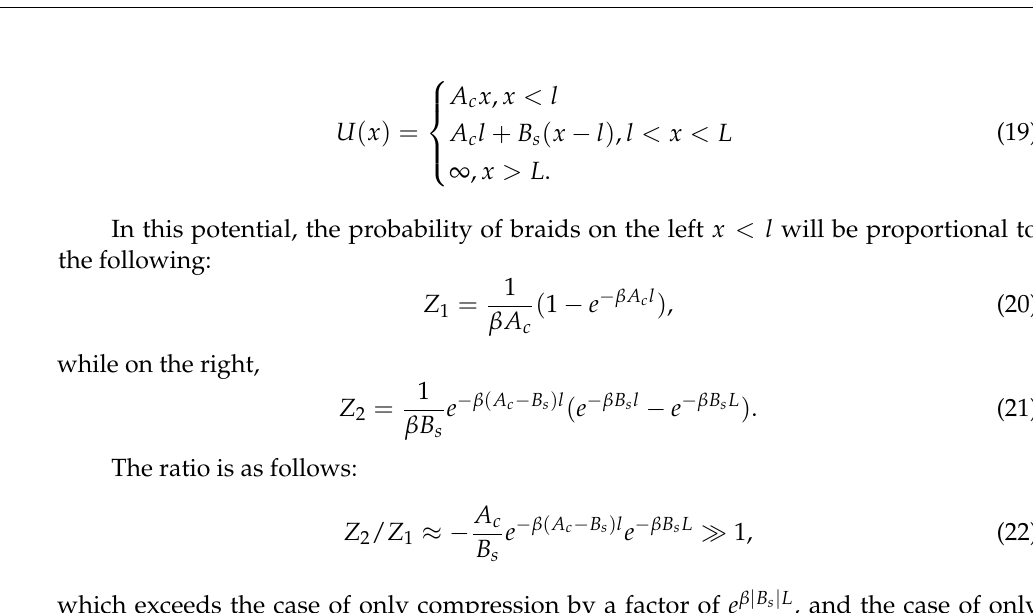
plotted as a function of aL a 2